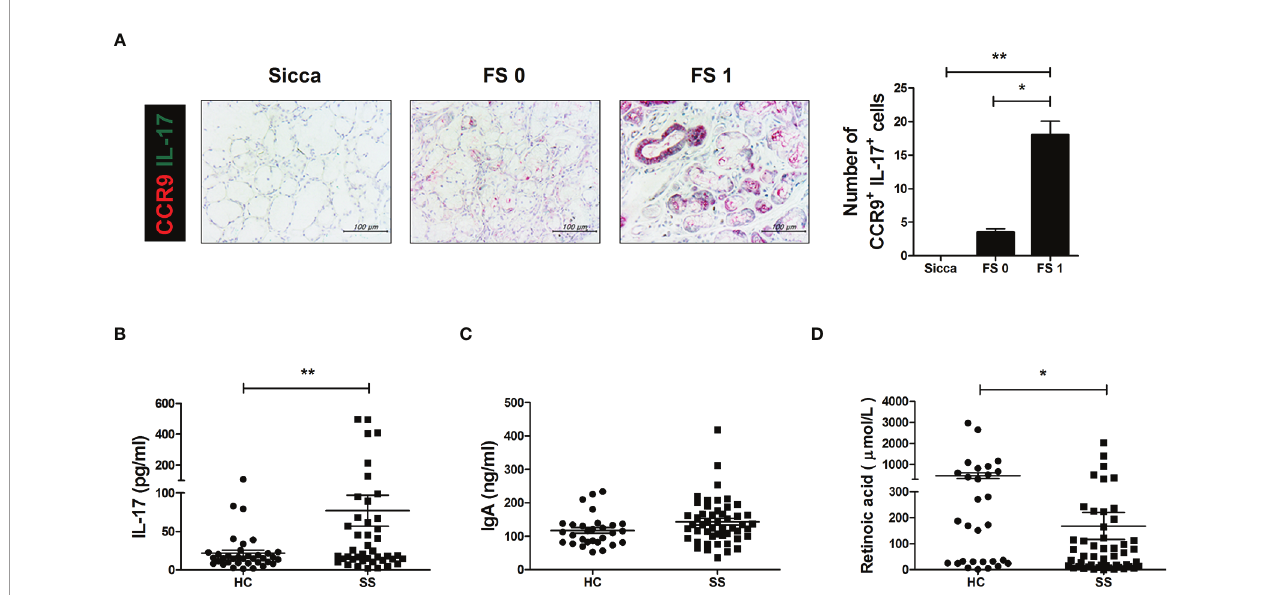
FIGURE 6 | IL-17 cells expressing gut-homing receptors in salivary glands and RA, IgA, and IL-17 levels in SS patient sera. (A) Representative CDR9- and IL-17- stained salivary glands from the indicated patient groups. Bar graph shows average numbers of CCR9 + IL-17 + cells in salivary gland tissues. (B – D) Bar graphs show average levels of IL-17 (B) , IgA (C) , and RA (D) in sera from healthy control (HC) and SS patients. Values are means ± SEM. * p < 0.05, ** p <